Question: Identify the chart type used in this figure.
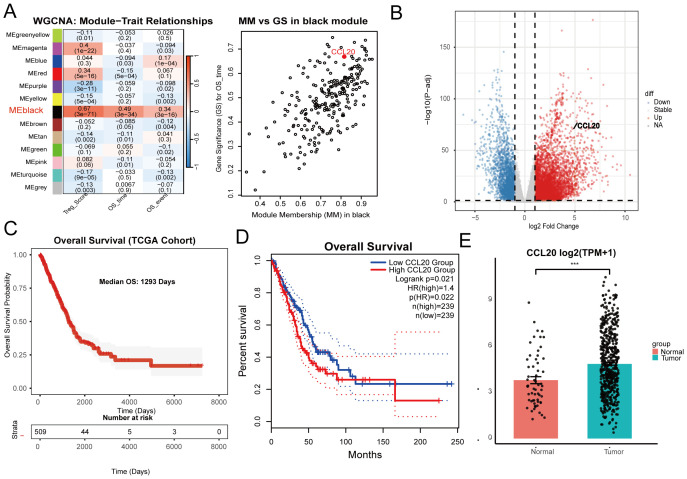
Answer: heatmap